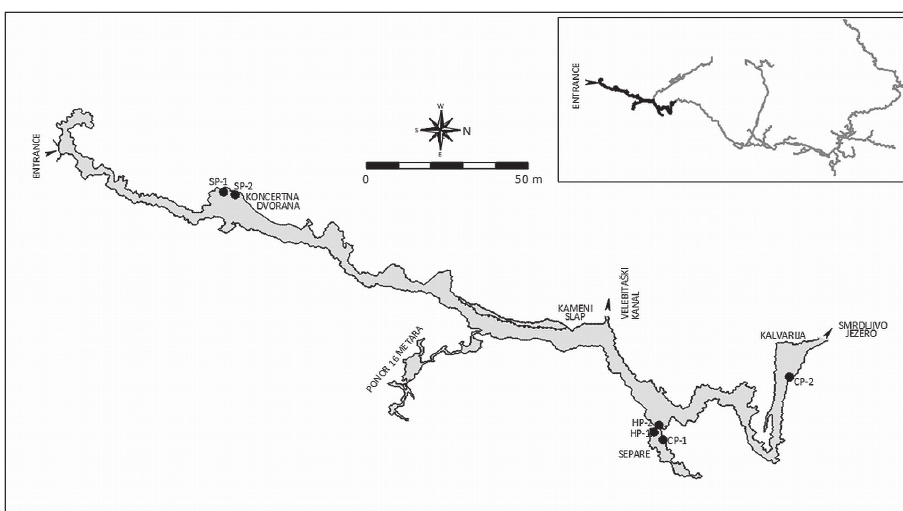
Figure 2. Map of the Veternica cave [adapted from Čapelak (1979)] with marked sampling sites (CP-clay pools; SP-sinter pools and